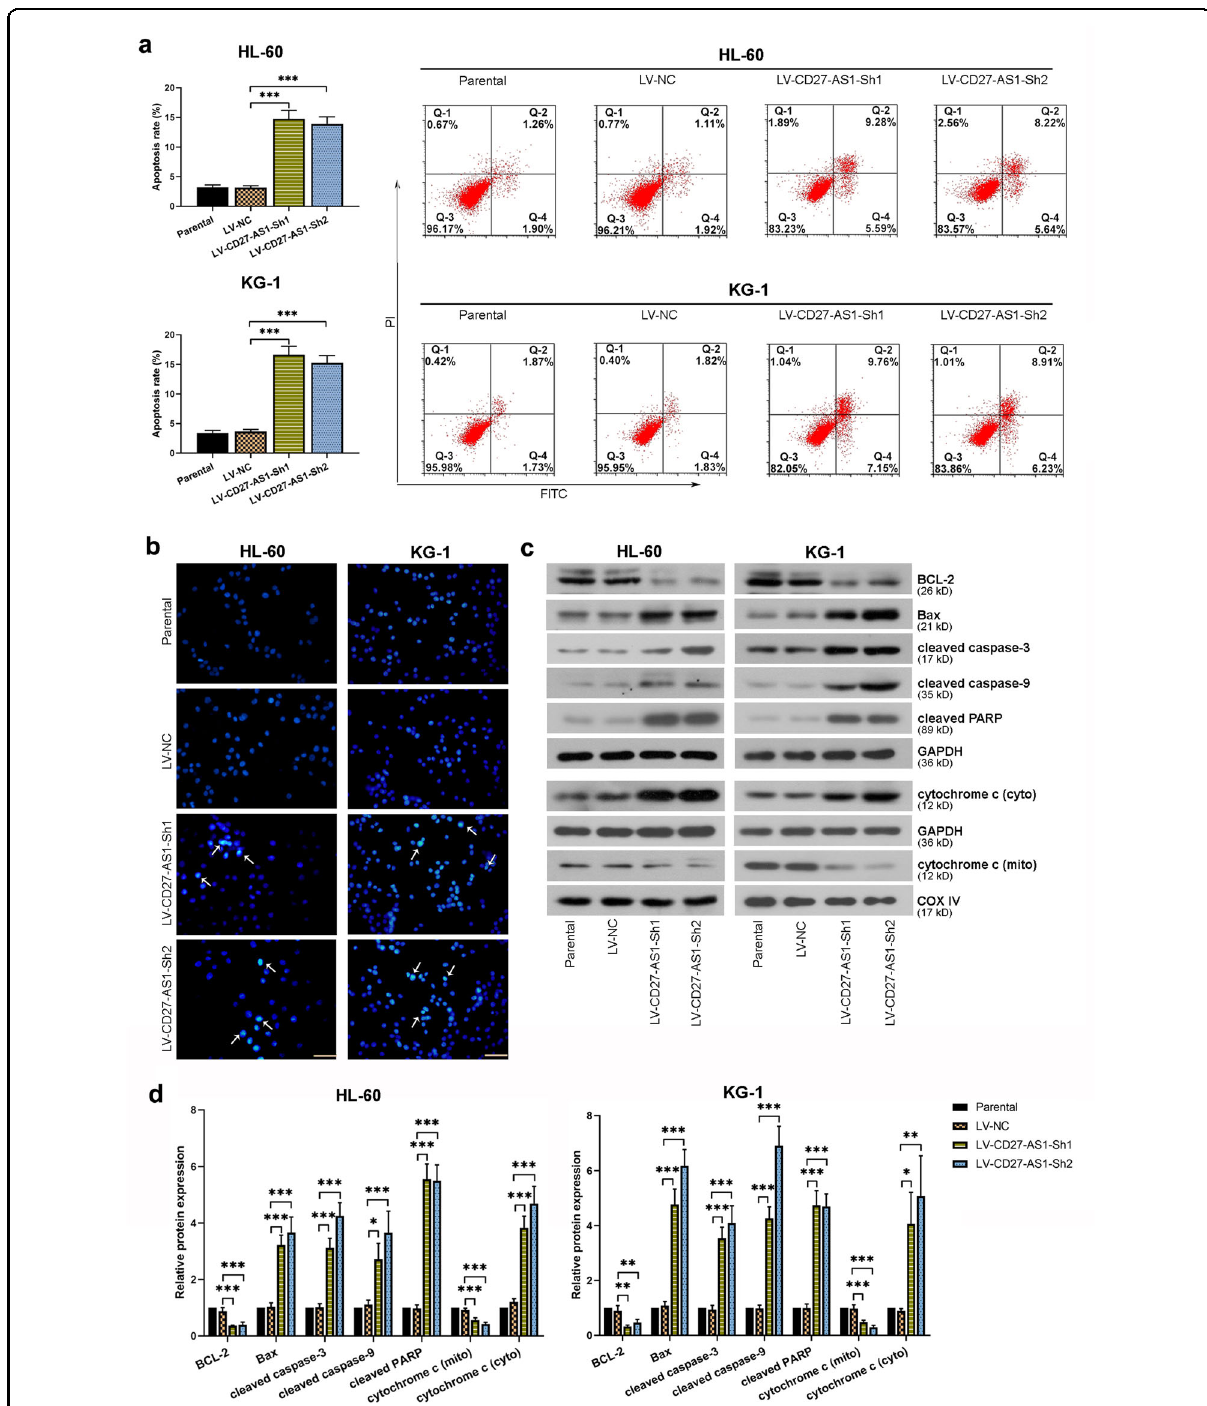
Fig. 4 Knockdown of CD27-AS1 enhances cell apoptosis in the AML cell lines. a Cell apoptosis was evaluated using fl ow cytometry in HL-60 and KG-1 cells after LV-CD27-AS1-shRNA infection. b Hoechst staining was performed in two AML cells with CD27-AS1 knockdown. c Western blotting assay showed relative protein levels of BCL-2, Bax, cleaved caspase-3, cleaved caspase-9, cleaved PARP, and cytochrome c in cytoplasm and mitochondria in the AML cells after infection. d Quantitative analysis of above protein levels in the HL-60 and KG-1 cells. N = 3. Data were shown as means ± SD. * P < 0.05, ** P < 0.01, and *** P <